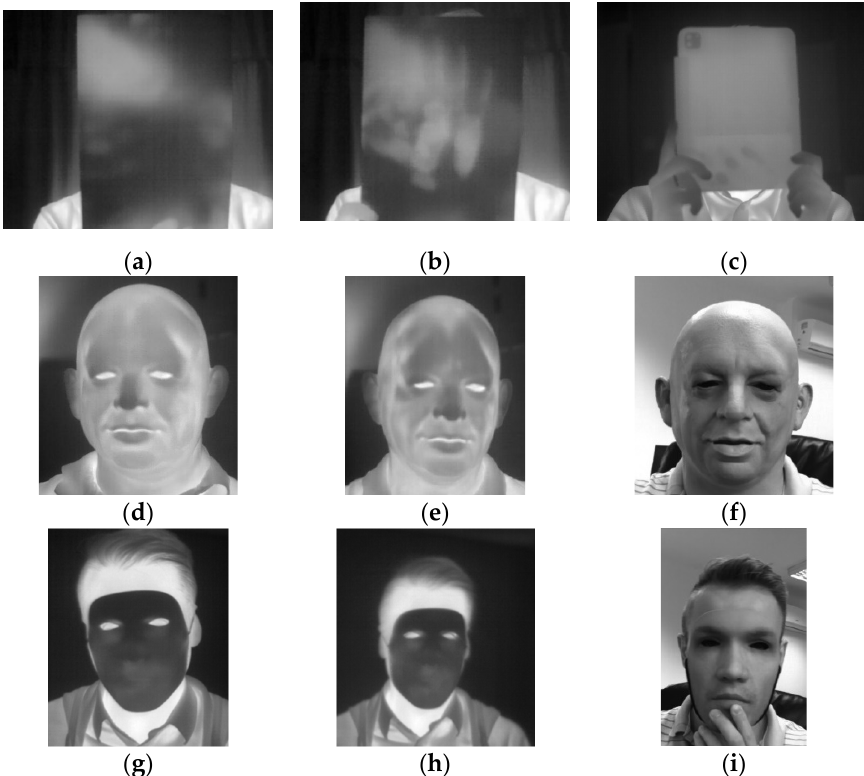
Figure 2. Thermal images presenting a subject face under various presentation attacks, ( a ) face photograph printed on a thin sheet of paper, ( b ) face photograph printed on a sheet of paper with a palm print, ( c ) photograph displayed on an Apple iPad screen, ( d ) subject wearing a latex full-face mask at the beginning of the experiment, ( e ) subject wearing a latex full-face mask at the end of the experiment; ( f ) subject wearing a latex full-face mask, monochrome visible range image, ( g ) subject wearing a 3D printed face mask at the beginning of the experiment, ( h ) subject wearing a 3D printed face mask at the end of the experiment and ( i ) subject wearing a 3D printed face mask, monochrome visible range